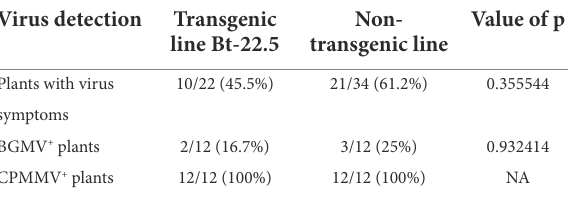
TABLE 2 Proportion of common bean cv. Olathe Pinto plants (non- transgenic) with virus symptoms, positive for BGMV and CPMMV by PCR, after inoculation by viruliferous whiteflies previously fed on the transgenic common bean line Bt-22.5 or on the non-transgenic plants for 48